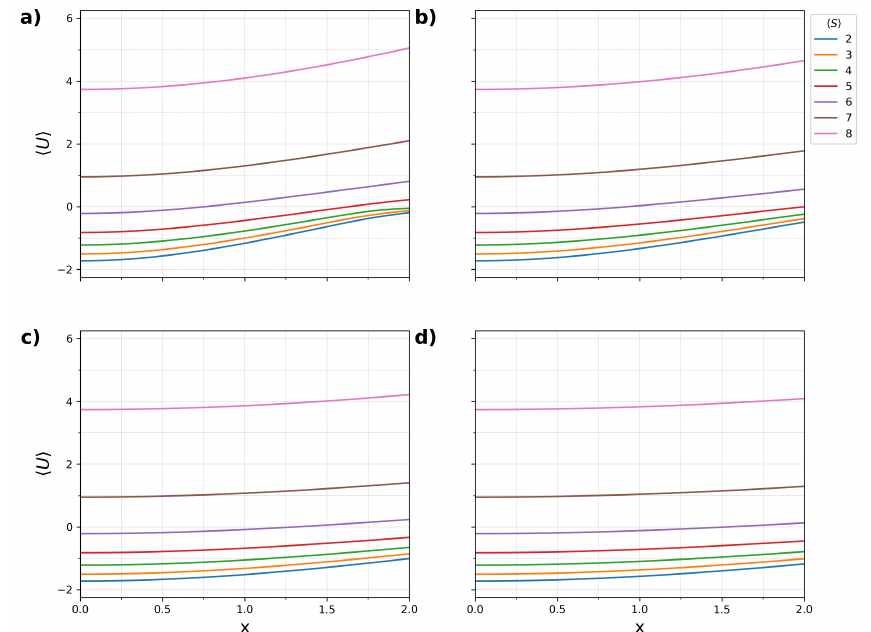
Figure 9. The behavior of the internal energy as a function of the dimensionless parameter x , at constant values of the entropy, is presented. The entropy S takes the values 2 to 8, in steps of one, in increasing order from the down curve to the up curve. As in the previous figures, ( a – d ) stand for values of the asymmetry parameter α = − 1.25, − 1.0, − 0.75, and − 0.362,